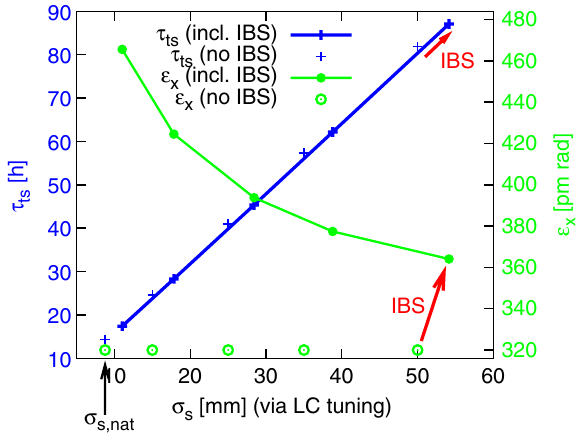
FIG. 6. Touschek lifetime and horizontal emittance as functions of bunch length which is adjusted by tuning the LCs. The stored current was assumed to be 500 mA with the vertical emittance always set to 8 pm rad. The calculated Touschek lifetime is based on resulting overall MA from tracking and actual vacuum apertures. The emittance blowup and bunch length increase from IBS as well as the associated lifetime increase are